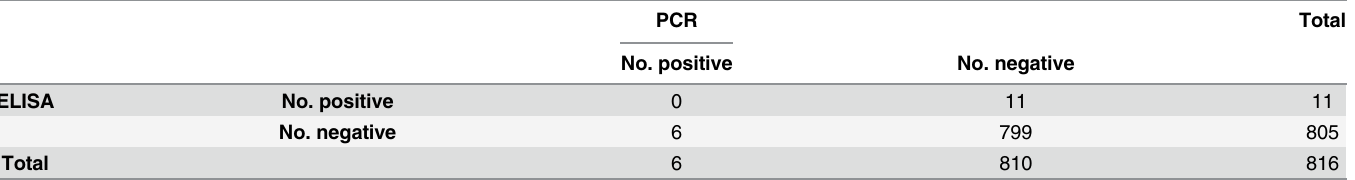
Table 2. Comparison of Coxiella detection by ELISA and